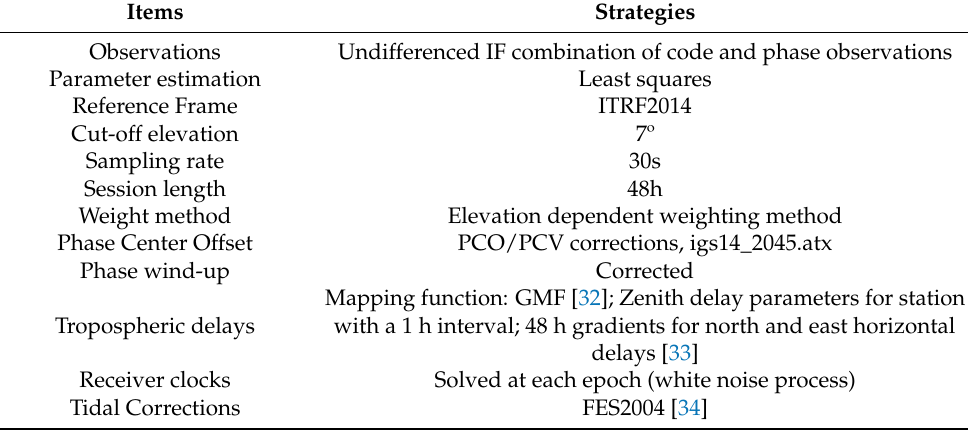
Figure 3. Station distribution. Table 1. PPP data processing strategies.